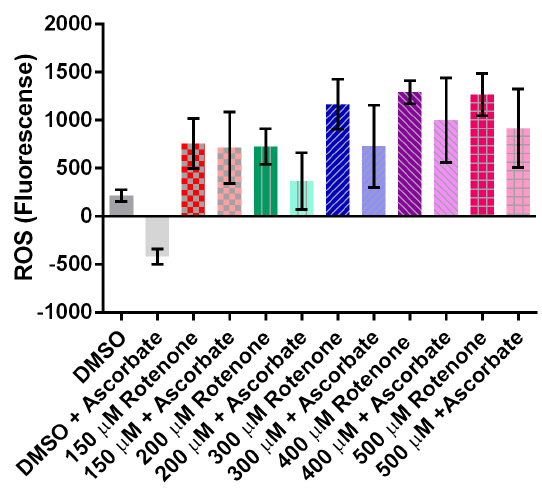
Figure 10. The effect of ascorbic acid on rotenone induced ROS. 10 mg/mL of ascorbic acid lowered ROS but not significantly ( n = 4). Error bars represent standard